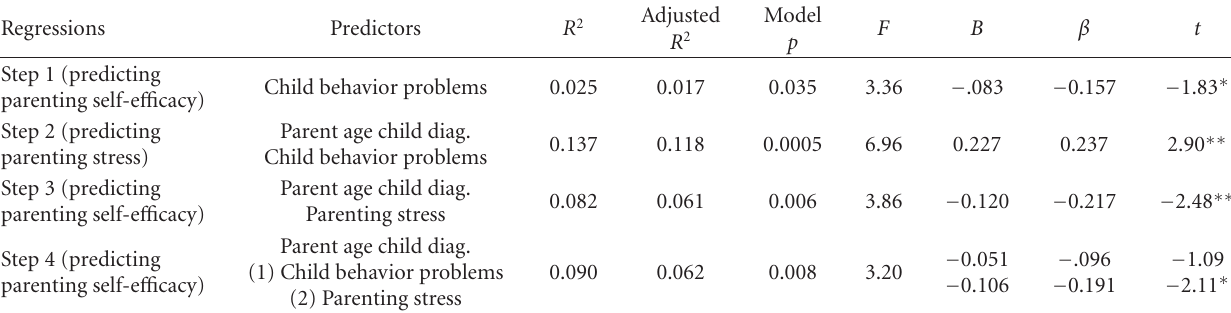
Table 3: Series of regression analyses for parenting stress as mediator child behavior problems and parental self-e ffi cacy.